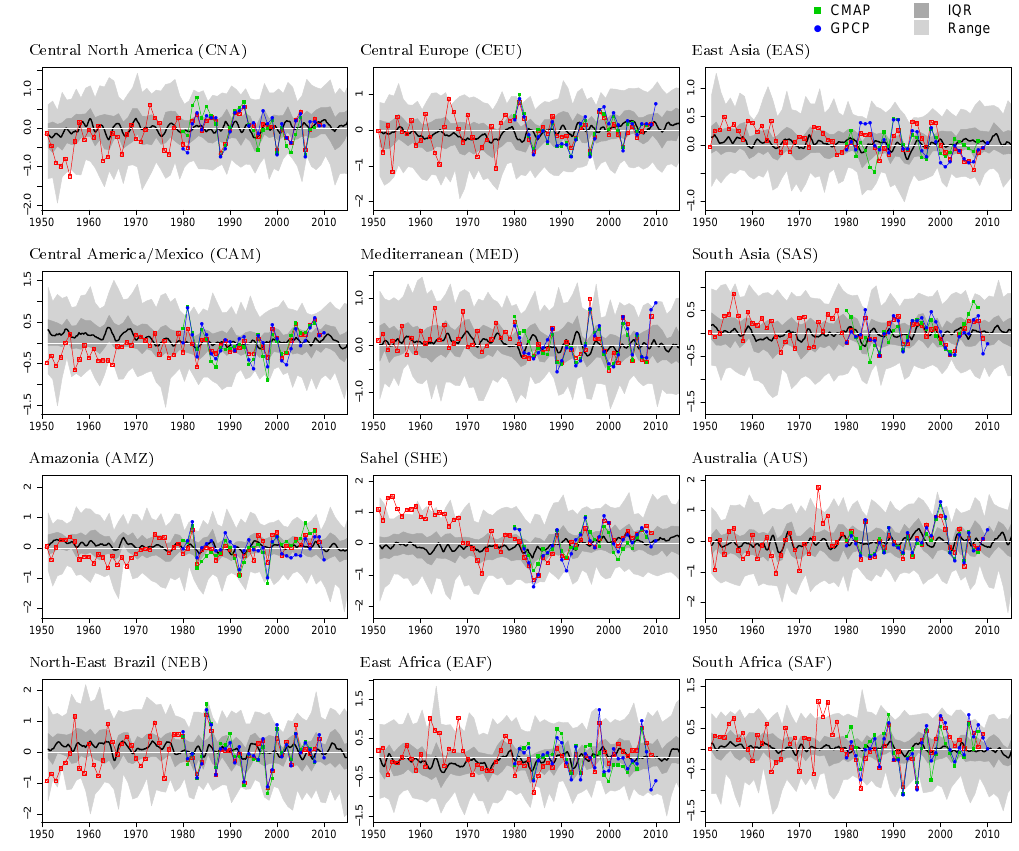
Fig. 3. Observation-based and CMIP5 simulated SPI12: annual averages of SPI12 values from three observation-based datasets (coloured lines) and median, inter-quartile range and total range across the CMIP5 ensemble (black line, dark grey and grey shading, respectively). Until 2005, CMIP5 data come from the historical simulations, after-wards, projections for the GHG concentrations scenario RCP8.5 are used. SPI12 values are calculated with respect to the 1979–2009 period for all